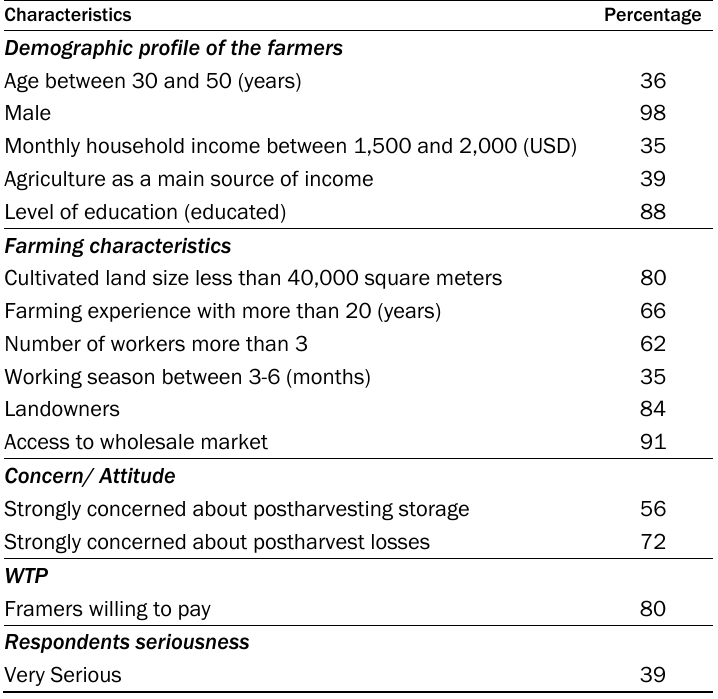
Table 2. Socio-Demographic Characteristics of the